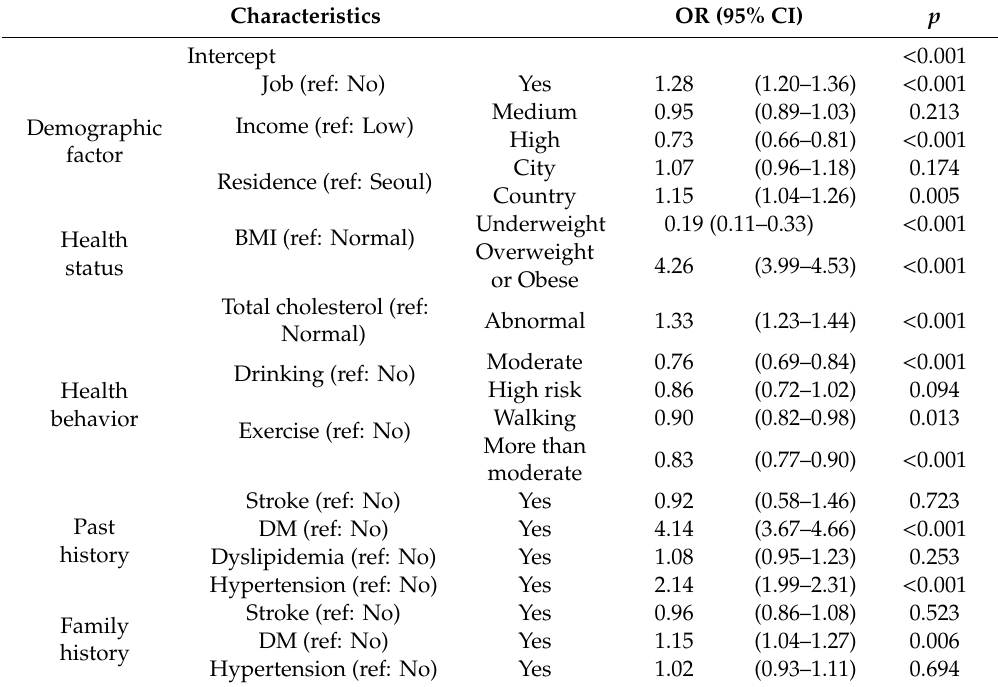
Table 4. Factors associated with metabolic